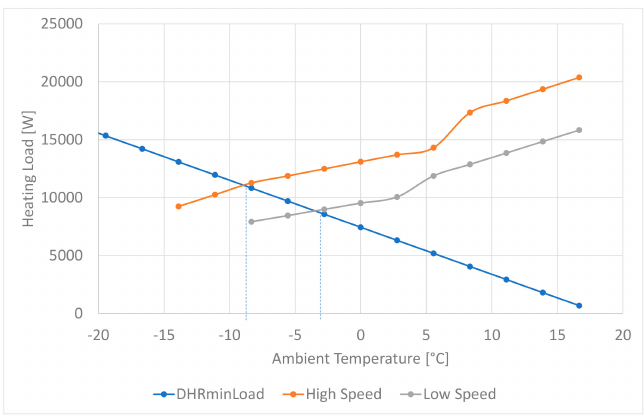
Figure 6. Heat pump capacities versus building load